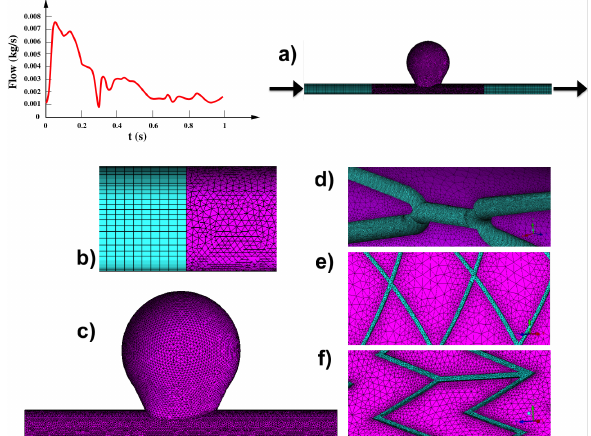
Figure 3. Model computational domains. ( a ) control case (in purple) including extensions (in light blue) and time-dependent mass flow extracted by [42] imposed at the inlet and at the outlet of the models. ( b ) Close-up view on the interface between the tetrahedral elements of the artery (in purple) and the hexahedral elements of the extension (in light blue). ( c ) Close-up view on the aneurysm and on the region of interest of the artery (in purple). ( d – f ) Close-up views showing local refinement around the stent struts for the three flow